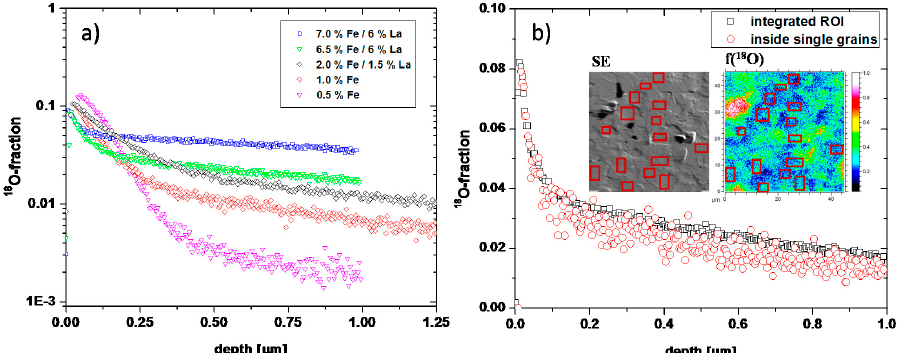
Figure 10. ( a ) Tracer depth profiles after diffusion at 560 °C for all Fe- and Fe/La-doped samples; ( b ) tracer depth profiles of 6.5% Fe/6% La with a region of interest (ROI) integrated over a larger area and ROIs situated within single grains (see SE inset), respectively. The second inset displays the lateral tracer distribution.